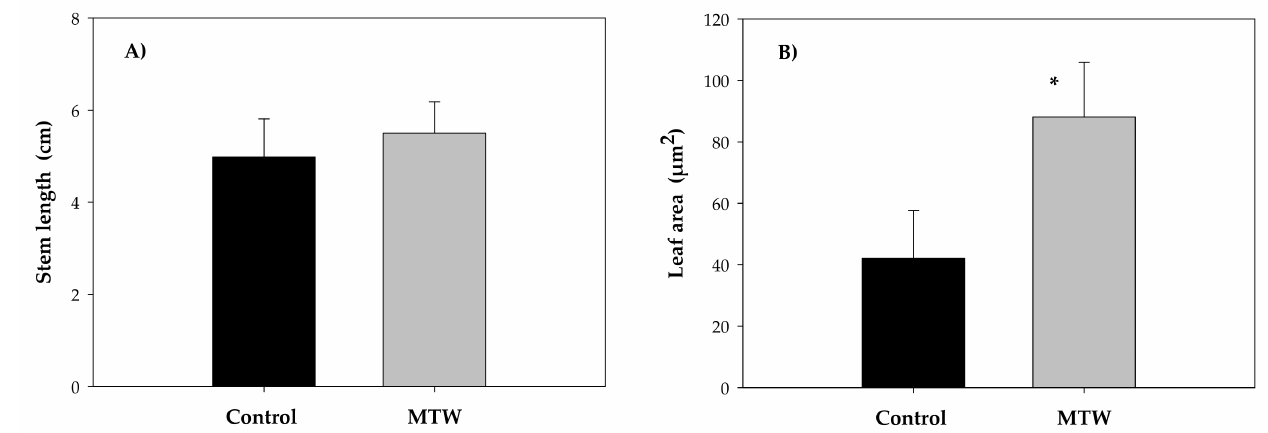
Figure 4. Mean values of stem length ( A ) and leaf area ( B ) in Phaseolus vulgaris L. grown with magnetically treated water. * indicates statistically significant differences ( p < 0.05). Control: plants grown without magnetically treated water, MTW: plants grown with magnetically treated water under a static magnetic field between 100 and 160 mT.